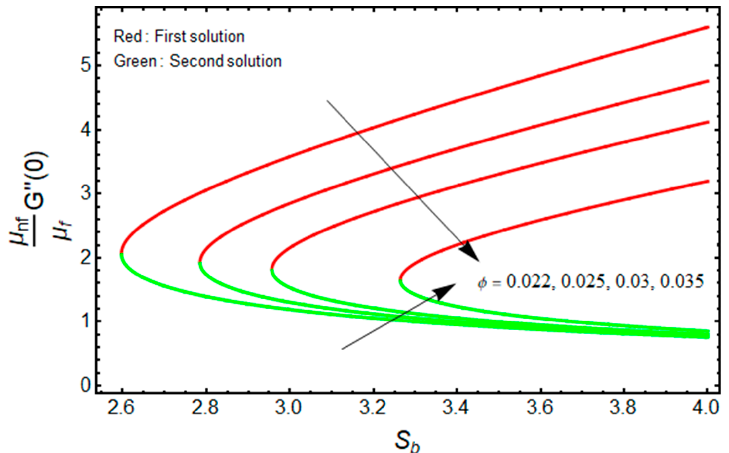
( ( ( (cid:16) (cid:17) G (cid:48)(cid:48) ( 0 ) versus S b when χ = 1, M b = µ nf / µ f